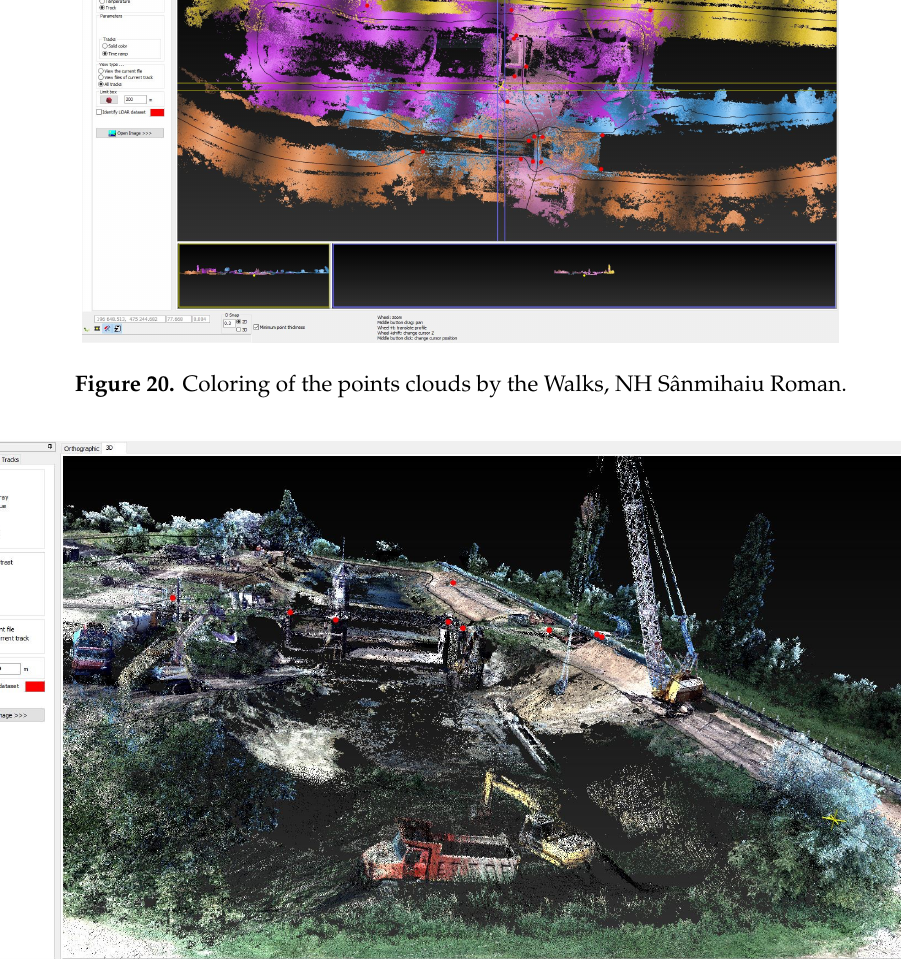
Figure 21. Restoration of Sânmihaiu Roman Lock, performed on 23 July 2019.